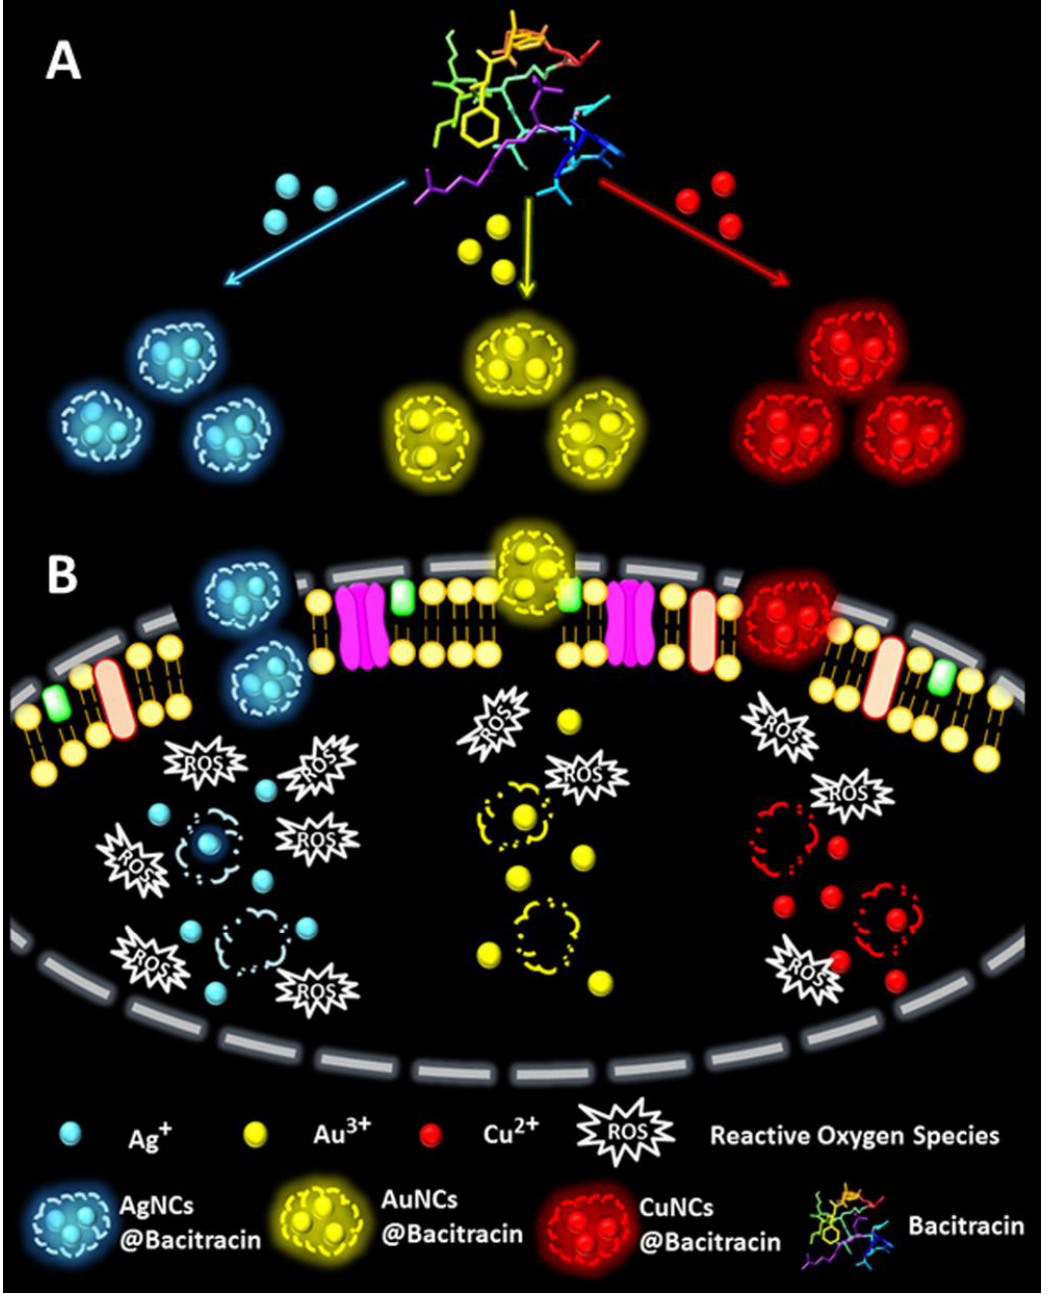
Figure 10. ( A ) Illustration of preparations of AgNCs@Bacitracin, AuNCs@Bacitracin,